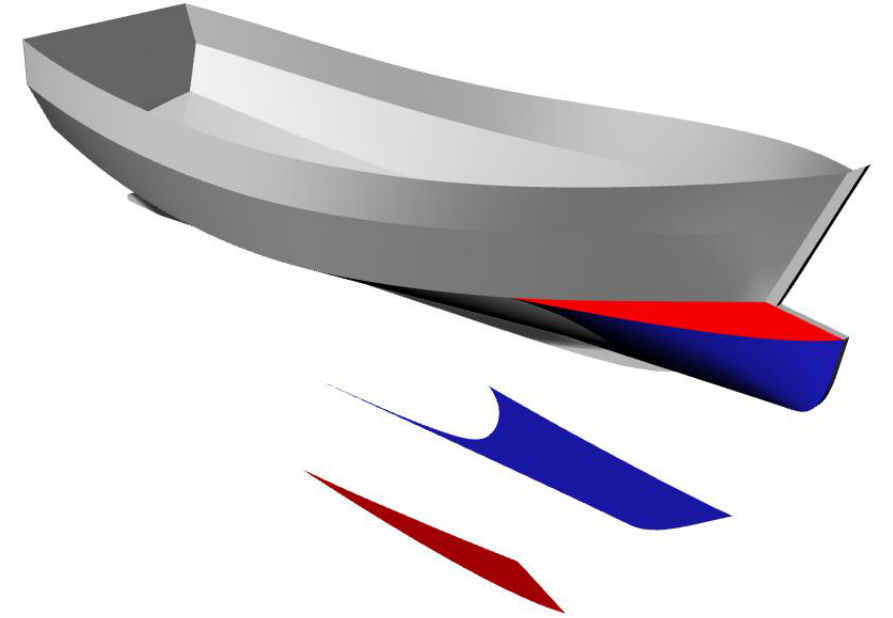
Figure 10. Unrolled dihedral bow of FAO2.